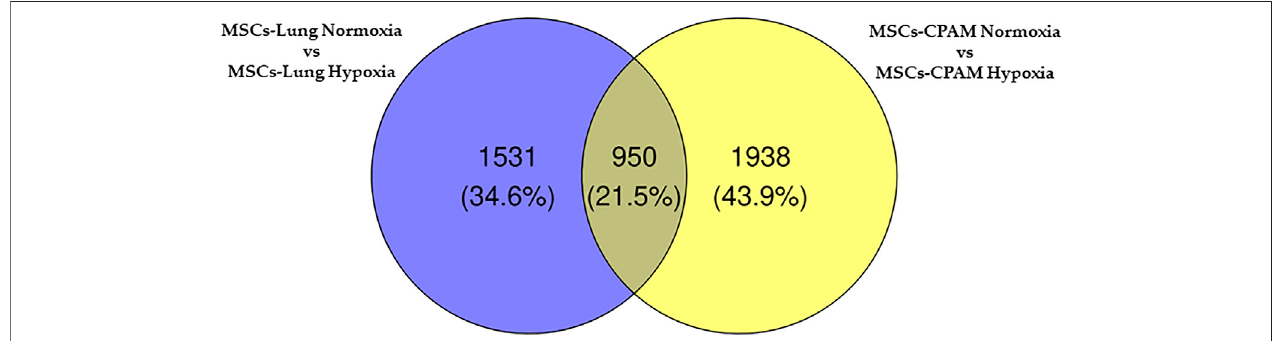
FIGURE 2 | Venn diagram of MSCs-lung and MSCs-CPAM in the different normoxia and hypoxia conditions. All the comparisons found 606 genes as different in statistical manner (the bottom intersection).